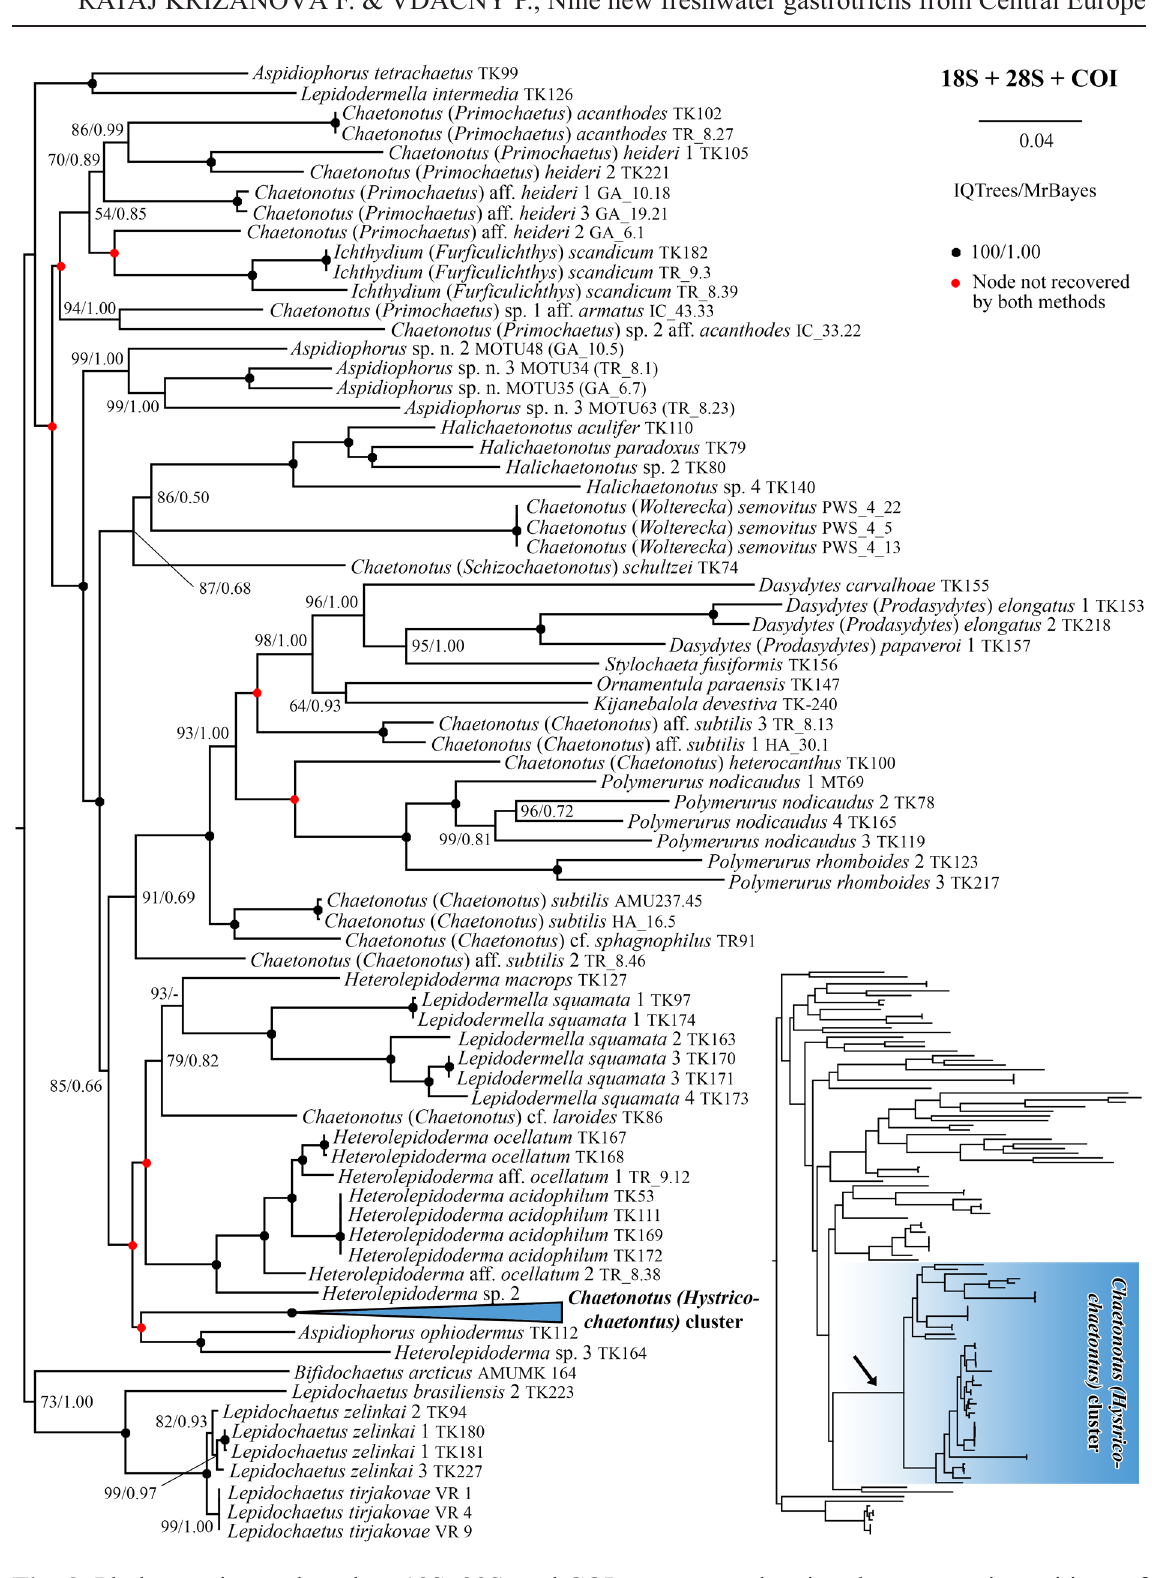
Fig. 8. Phylogenetic tree based on 18S, 28S, and COI sequences, showing the systematic positions of the Chaetonotus ( Hystricochaetonotus ) cluster (arrow). This clade is collapsed in the three, highlighted in the inset phylogram, and presented in detail in Fig. 9. ML bootstrap values and posterior probabilities were mapped onto the best ML